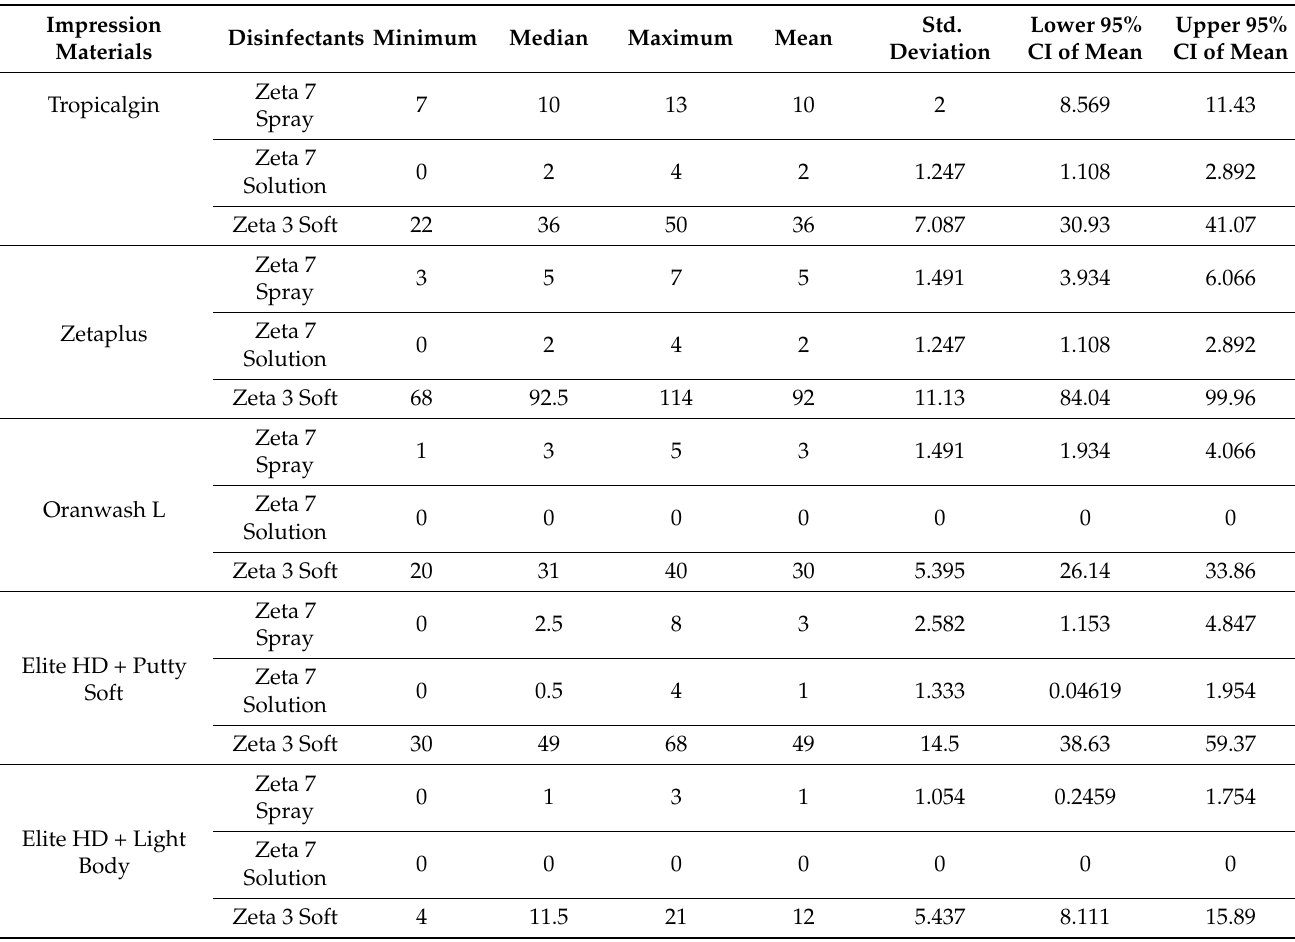
Table 5. Descriptive statistics of the values obtained after disinfection.